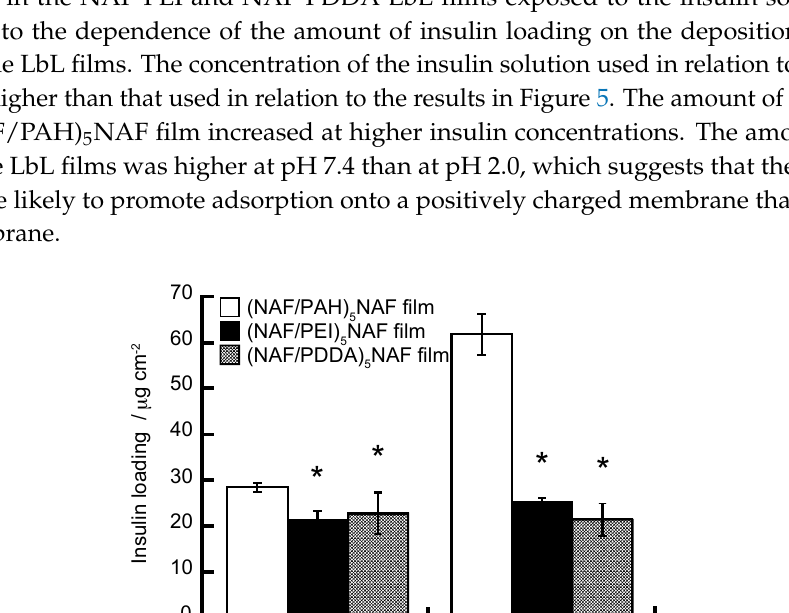
Table 1. Amount of insulin loading in LbL films.